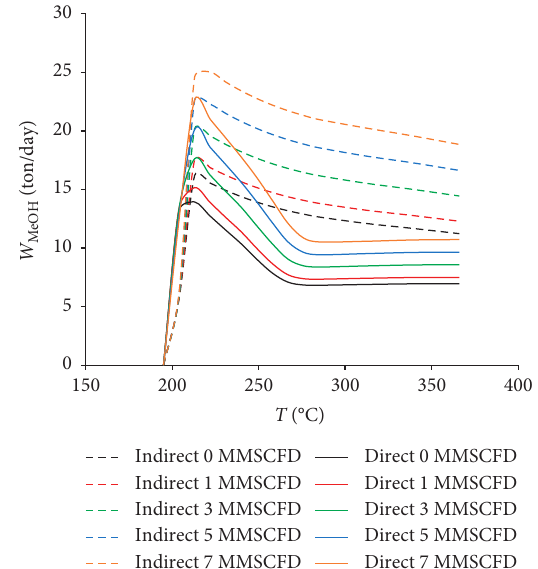
Figure 5: Effects of reactor temperature, T , at a pressure of 40 bar in the indirect and the direct processes on the methanol pro- duction, W MeOH , at various unreacted gas recycle